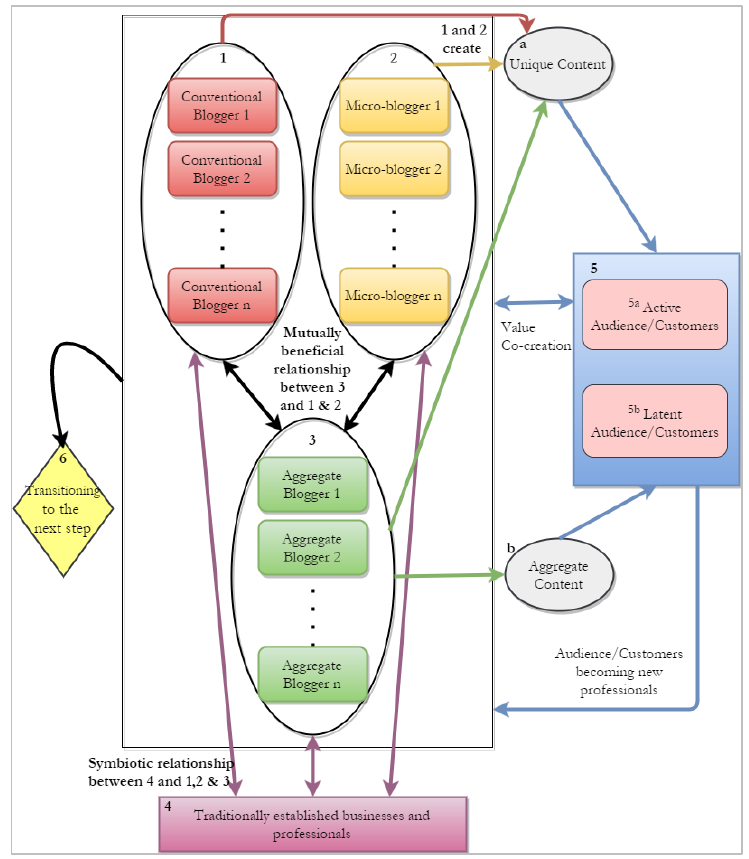
Figure 5. Value creation and co-creation interactions